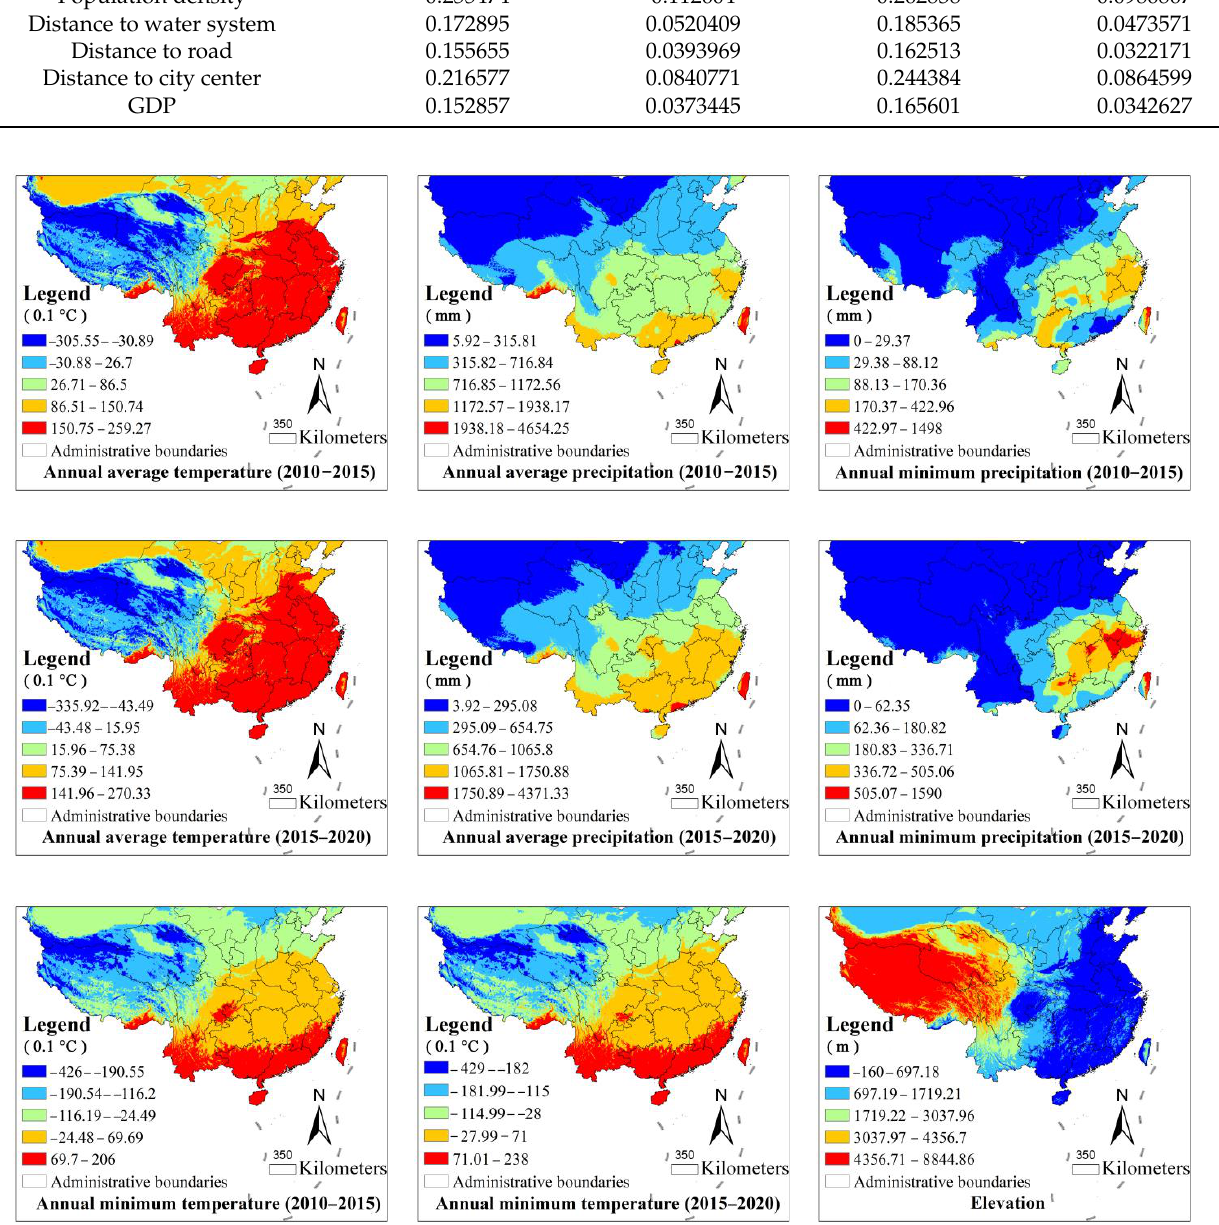
Figure 6. Spatial distribution of driving factors(1).